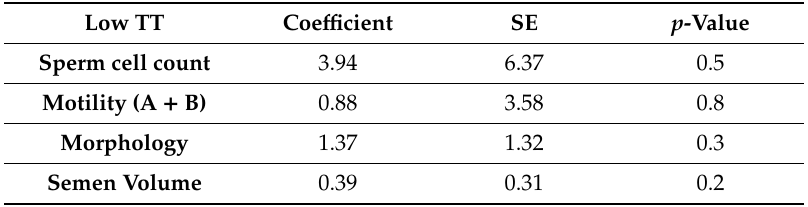
Table 3. Multivariable regression analysis for the e ff ect of low TT on semen parameters after adjustment for age, smoking status and